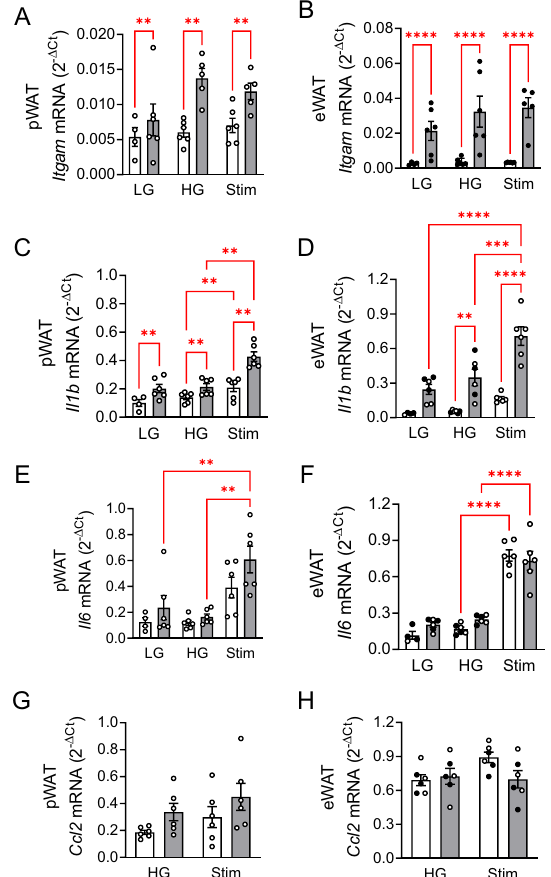
Figure 6. Beta-adrenergic stimulation increases Il1b and Il6 mRNA levels in adipose tissue. Cellular mRNA was isolated from ( A, C, E, G ) pWAT and ( B, D, F H ) eWAT pads used in the co-incubation experiments shown in Fig. 4 (CD mice, white bars) and Fig. 5 (HFD mice, grey bars) under low (2.8 mM, LG) and high (12 mM, HG) glucose and stimulation (12 mM glucose + Isopro + Yohim, Stim). Relative mRNA levels to Rps13 are presented as means ± SEM of the number of individual observations shown in each bar. * p < 0.5, ** p < 0.05, *** p < 0.05, **** p < 0.001 denote significant